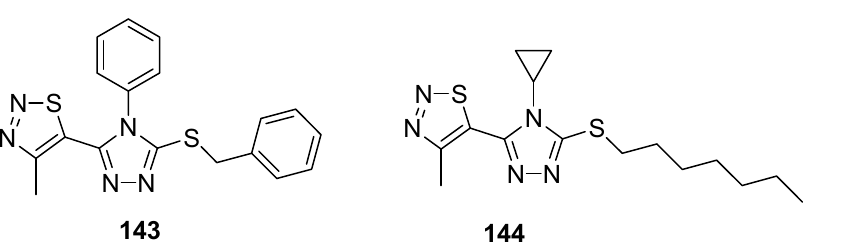
142 Figure 27. Novel potent 1,2,3-thiadiazole fungicides 141 and 142 . Another example of compounds with good antifungal activities are new structures designed by Sun et al., which are 1,2,4-triazole derivatives substituted with a 1,2,3-thiadiazole ring [82]. One of the synthesized compounds 143 (Figure 28), exhibited remarkably high fungicidal 93.19% against Corynespora cassiicola, while reference com- pounds iprodione, validamycin and topsin-M possessed 78.20, 53.52 and 78.75% anti- fungal activity, respectively. The authors declared that compound containing phenyl group on triazole ring 143 exhibited higher activity, however, the results were different in the case of Pseudoperonospora cubensis as compound 144 containing cyclopropyl group